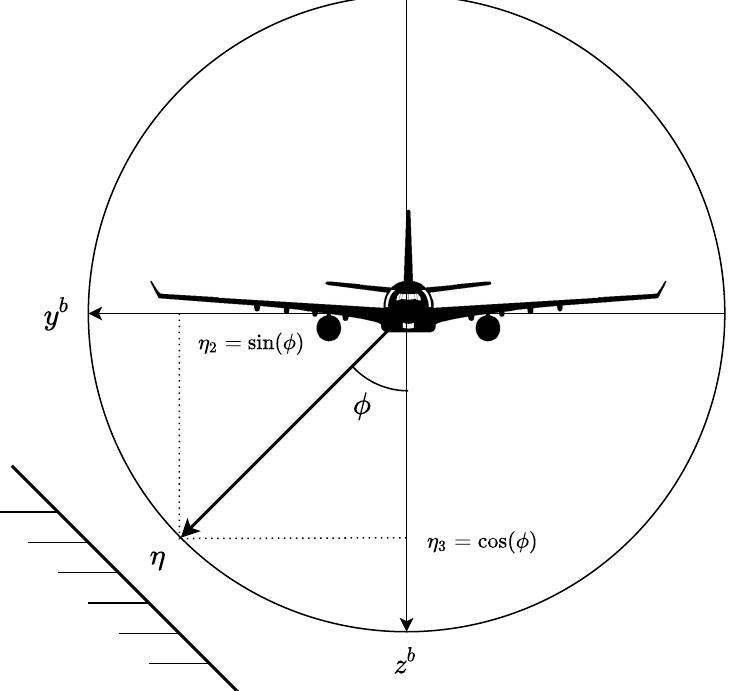
Figure 2. Reduced-attitude representation illustrated with a section of the two-sphere corresponding to θ =